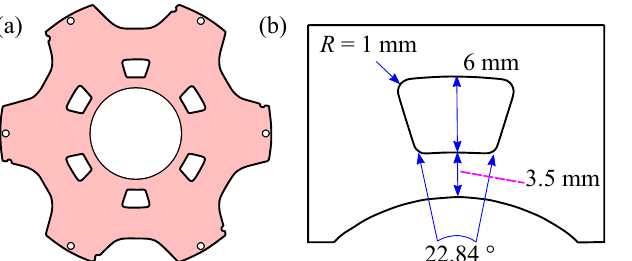
Figure 28. Rotor cut-outs for mass reduction: ( a ) rotor cross-section view and ( b ) dimensions of the